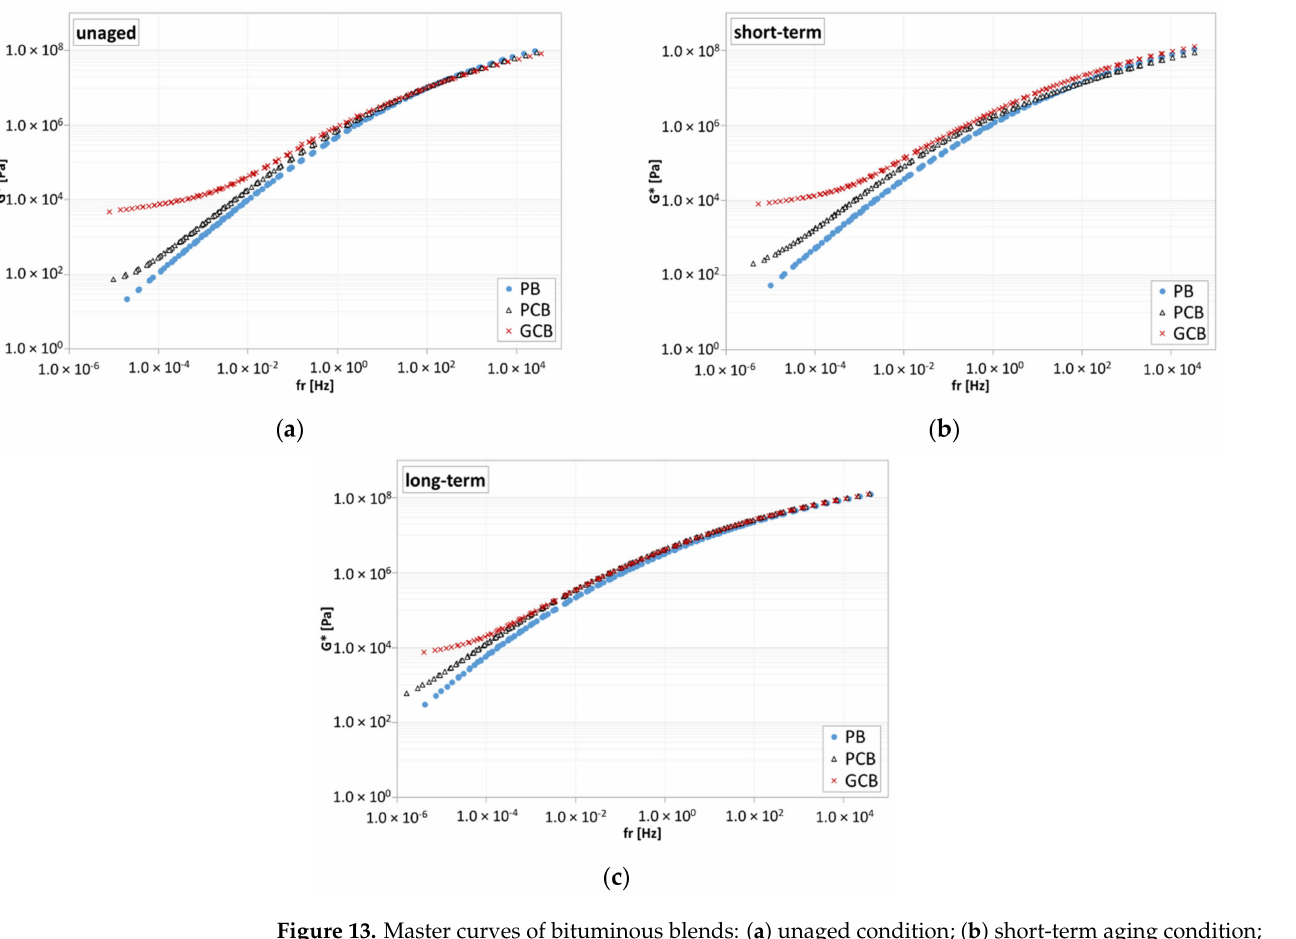
Figure 13. Master curves of bituminous blends: ( a ) unaged condition; ( b ) short-term aging condition; ( c ) long-term aging